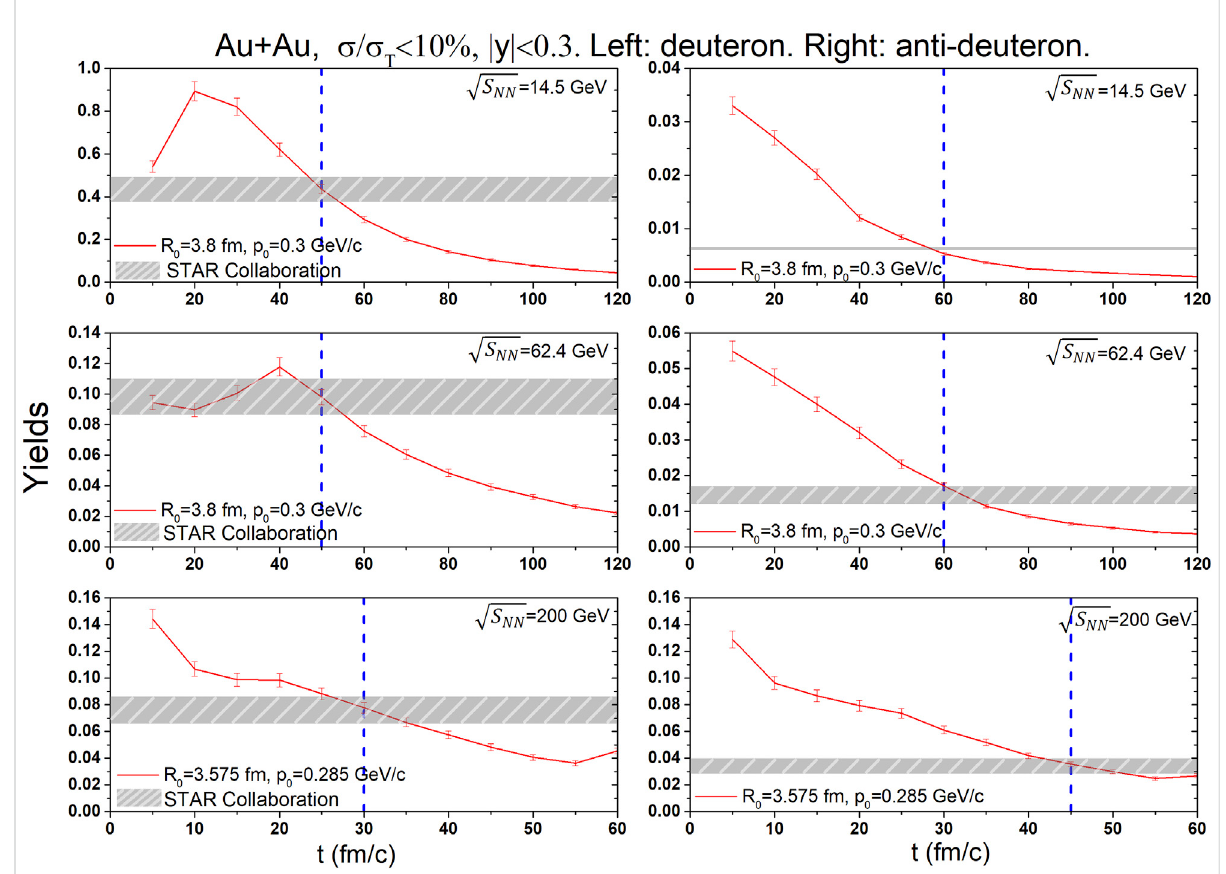
FIGURE 4 Theyieldsof(anti-)deuteronsasthetimeevolutioninAu+Aucollisionsat centrality. The lines are the calculations under certain conditions ( R 0 , P 0 ). The shaded bands are the corresponding experimental data which taken from the STAR Collaboration [27]. The dash lines are orientation